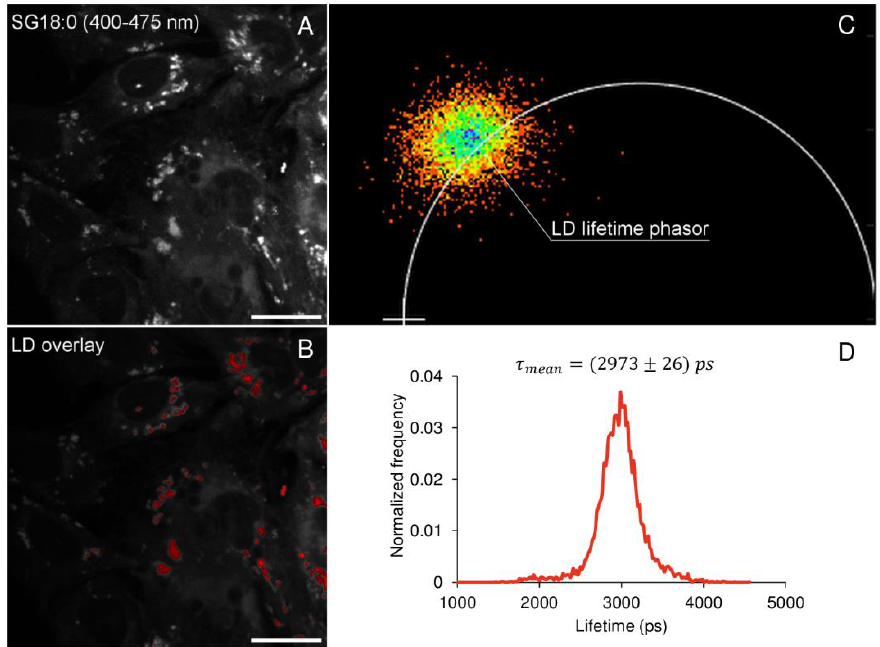
Figure 5. Nile Red colocalization experiment: lifetime distribution of lipid droplets. ( A ) The inte- grated fluorescence emission intensity of SG18:0 in the wavelength range 400–475 nm. In ( B ) the mask of lipid droplets, obtained by integrating the Nile Red fluorescence emission between 575 and 600 nm and taking into account the 2 percentile of the brightest pixels to remove background overlapped to the image (red). The application of this mask to the SG18:0 lifetime emission image identifies the subset of points in the phasor plot that corresponds to the LD lifetime ( C ). The graph in ( D ) shows the lifetime distribution of LD, reported as the normalized frequency of pixels ( y -axis) characterized by a certain lifetime ( x -axis). The mean value ± standard deviation of LD lifetime was obtained by averaging the lifetime distribution from n = 25 cells.